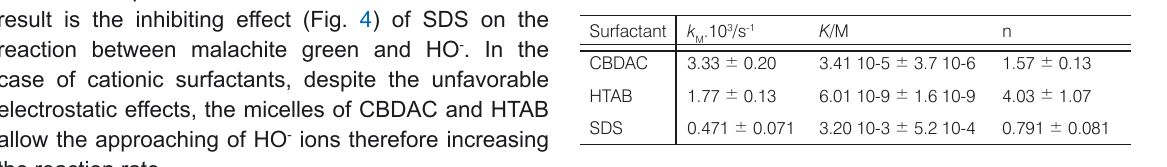
Table 1. Kinetic parameters of equation